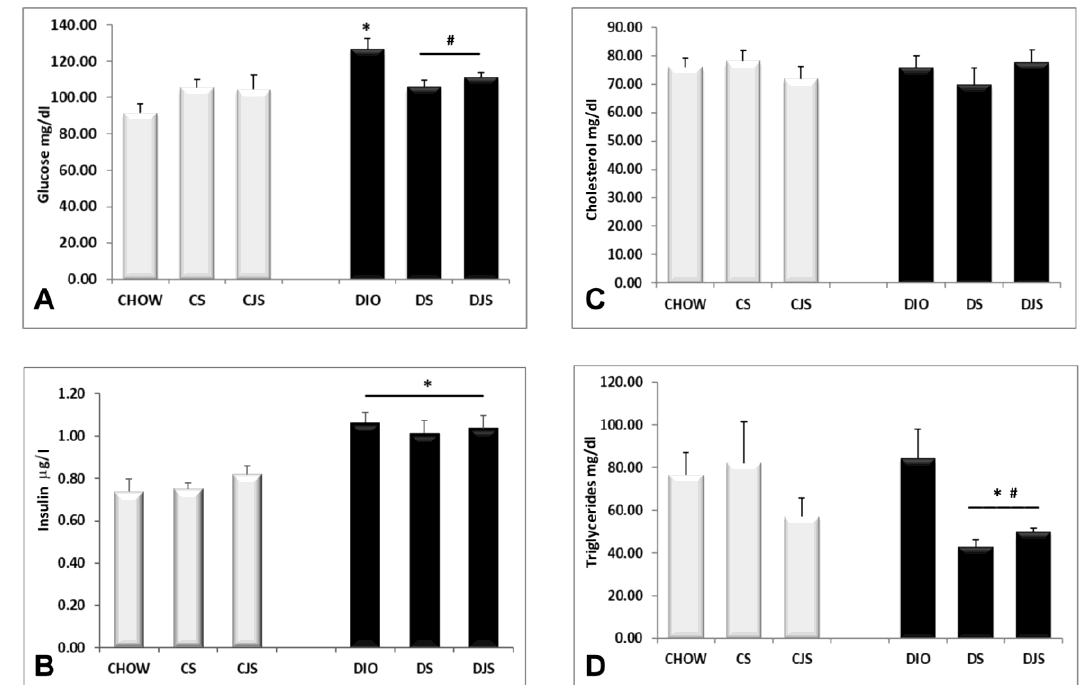
Figure 2. Blood parameters. Levels of ( A ) glucose in mg/dl, ( B ) insulin in μg/l, ( C ) cholesterol, and ( D ) triglycerides in mg/dl, measured at the end of the study in all of the animal groups. CHOW—control rats with standard diet; CS—CHOW plus tart cherry seeds; CJS—CHOW plus tart cherry seeds and juice; DIO—diet-induced obese rats; DS—DIO plus tart cherry seeds; DJS—DIO plus tart cherry seeds and juice. Data are the mean ± SEM. * p < 0.05 vs. CHOW rats; # p < 0.05 vs. DIO rats.